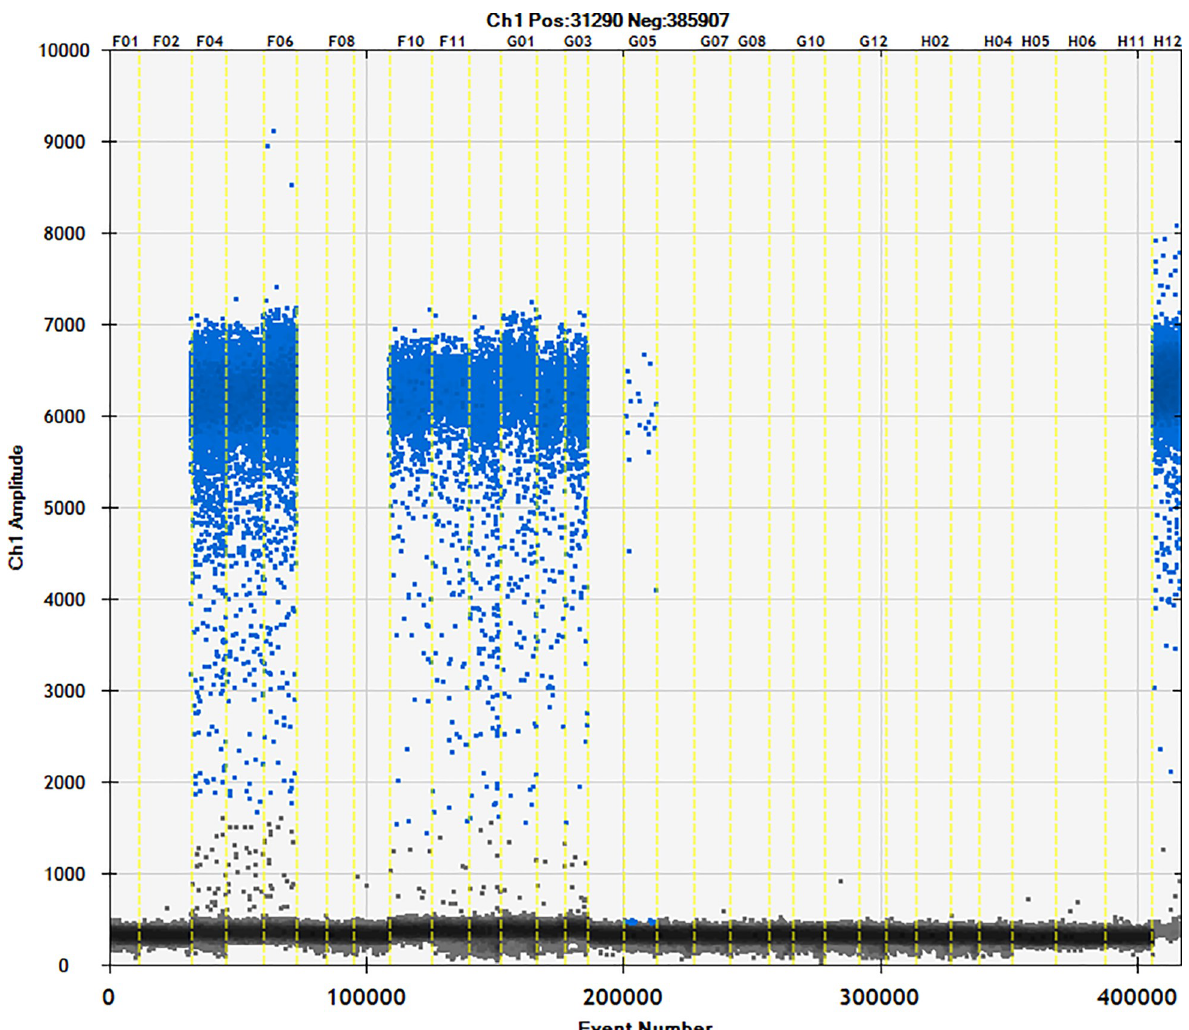
Fig 8. Actual test of commercially available samples. Channel 1–3: sample21; channel 4–6: sample22; channel 7–9: sample23; channel 10–12: sample24; channel 13–15: sample25; channel 16–18: sample26; channel 19–21: sample27; channel 22–24: sample28; channel 25–27: sample29; channel 28–30: sample30; channel31 negative; channel32